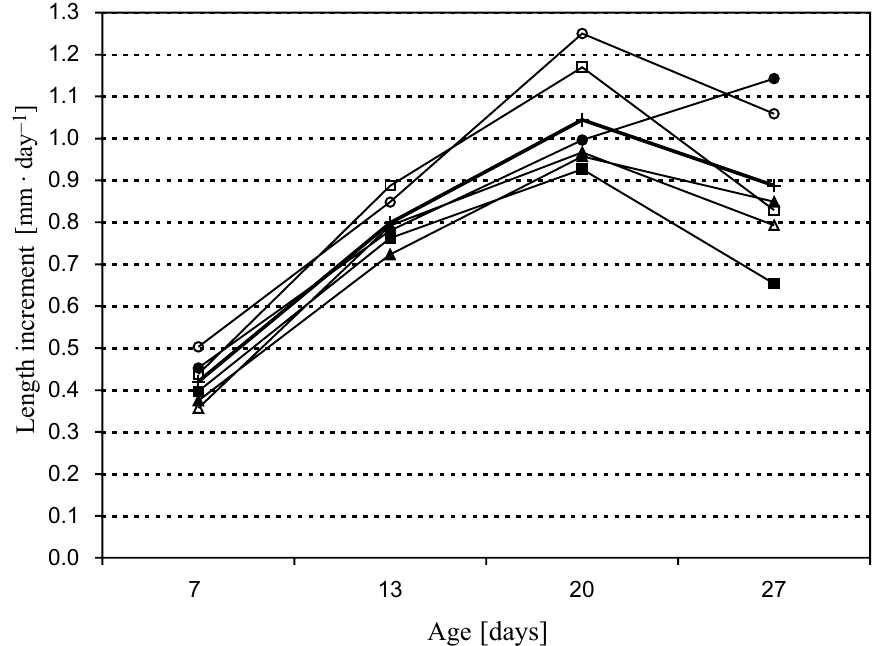
Fig. 2. Growth rate of pike larvae during growing-out operation in tanks with different habitats; tanks with black garden polyeth- ylene foil (F1, F2) denoted with ! and " ; tanks with vascular plants (R1, R2) denoted with " and # ; tanks with plastic net- ting (S1, S2) denoted with ! and " ; 1, 2, replicates; arithmetic mean denoted with